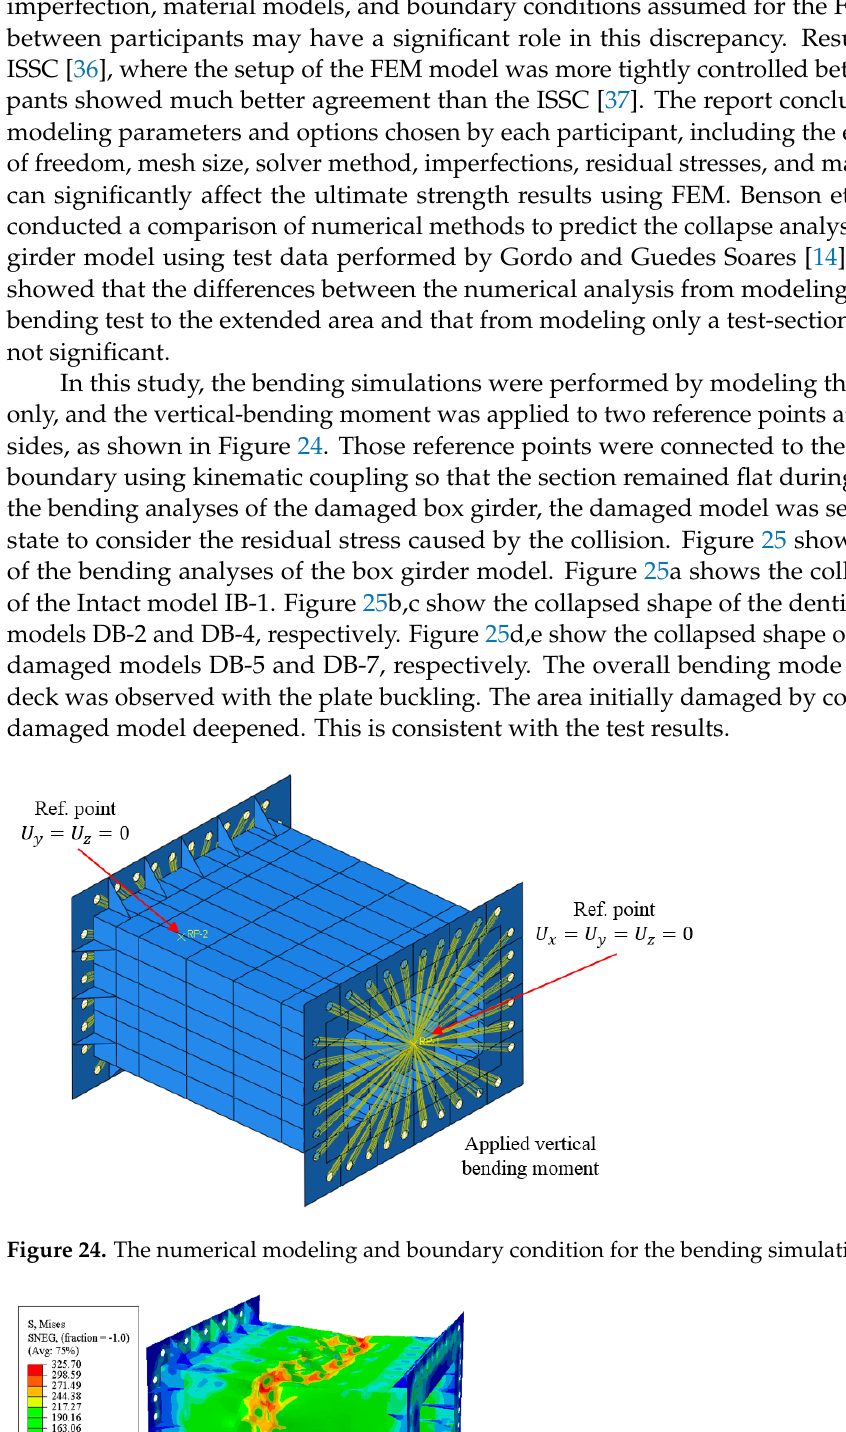
( e ) Figure 25. Collapsed shapes of the box girder models: ( a ) IB-1; ( b ) DB-2; ( c ) DB-4; ( d ) DB-5; ( e ) DB- 7. 6. Discussion 6.1. Frictional Force Estimation Frictional forces are generated between the model and the supporting structure un- der a large lateral load. Therefore, the frictional forces were estimated using the strain